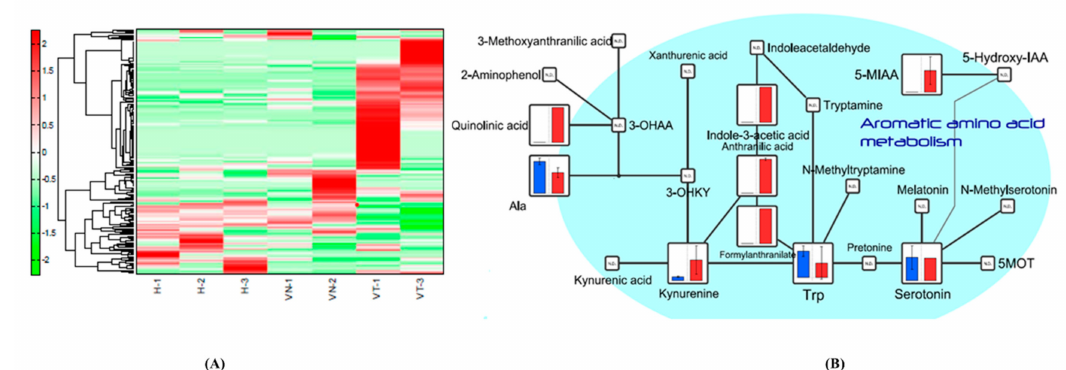
Figure 2. Serotonin pathway map and kynurenine pathway map with the obtained metabolome data from exploratory metabolome profiling analysis (cropped). Notes: Hierarchical cluster analysis was performed using the relative peak area of putative metabolites from seven serum samples, including from two subjects in the VAKI group (VT-1 and VT-3), two subjects in the infection subgroup (VN-1 and VN-2), and three HCs (H-1, H-2, and H-3) ( A ), and the metabolomics pathway map was created using the VANTED software ( B ). The blue and red boxes represent the mean relative peak area of the component in non-VAKI subjects and VAKI subjects, respectively. The cropped serotonin pathway map and kynurenine pathway map showed that VAKI subjects had significantly increased concentrations of indolic compounds such as 3- indoxylsulfuric acid, IAA, and 5-MIAA compared with non-VAKI subjects. Abbreviations: 3-OHAA, 3-hydroxyanthranilic acid; 3-OHKY, 3-hydroxykynurenine; 5-MOT, 5- methoxytryptamine; 5-hydroxy-IAA, 5-hydroxyindoleacetic acid; 5-MIAA, 5-methoxyindole-3-acetic acid; Ala, alanine; Trp, tryptophan; VANTED, Visualization and Analysis of Networks Containing Experimental